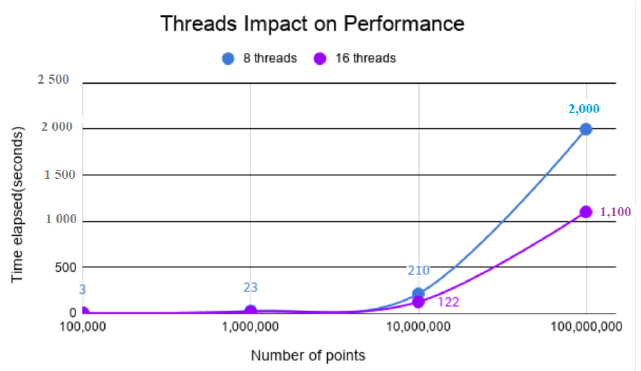
Figure 1. Threads impact on